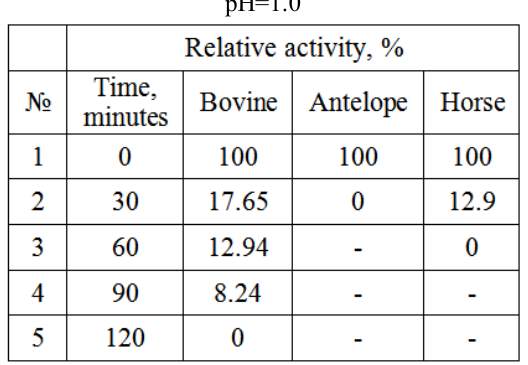
Table 5. Acid influence on the enzyme activity, рН=1.0